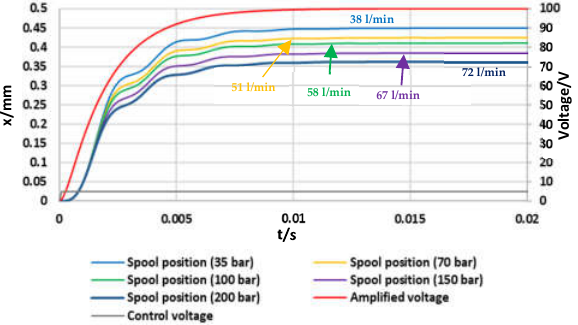
Figure 8. Open-loop step tests simulated for different values of p P − p T ( C p = 90 Ns/m; m p = 80 g; ω n , a = 1400 rad/s).